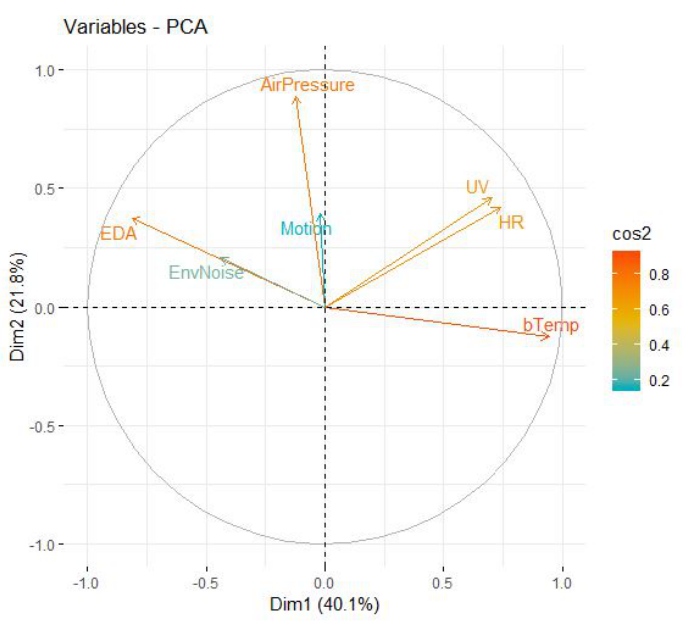
Figure 12. PCA plot of Body features with environmental